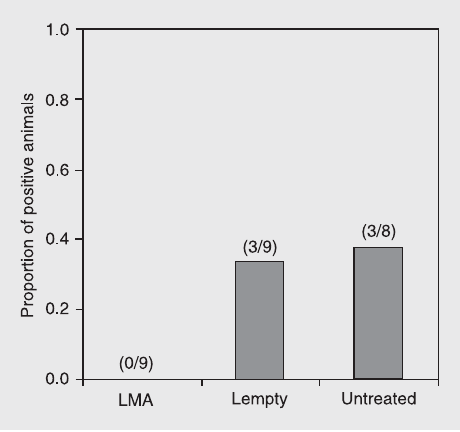
Figure 2. Proportion of dogs positive for Leishmania para- sites 30 days after multiple dose treatment with liposome-encap- sulated meglumine antimoniate (LMA group) or empty liposomes (Lempty group), and in the un- treated group. Animals were considered to be positive when bone marrow aspirates showed at least one amastigote per 1000 host cell